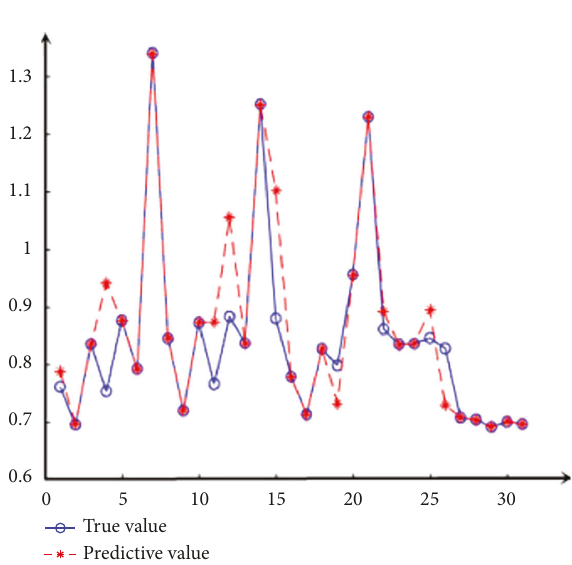
Figure 25: Optimized warpage test diagram.